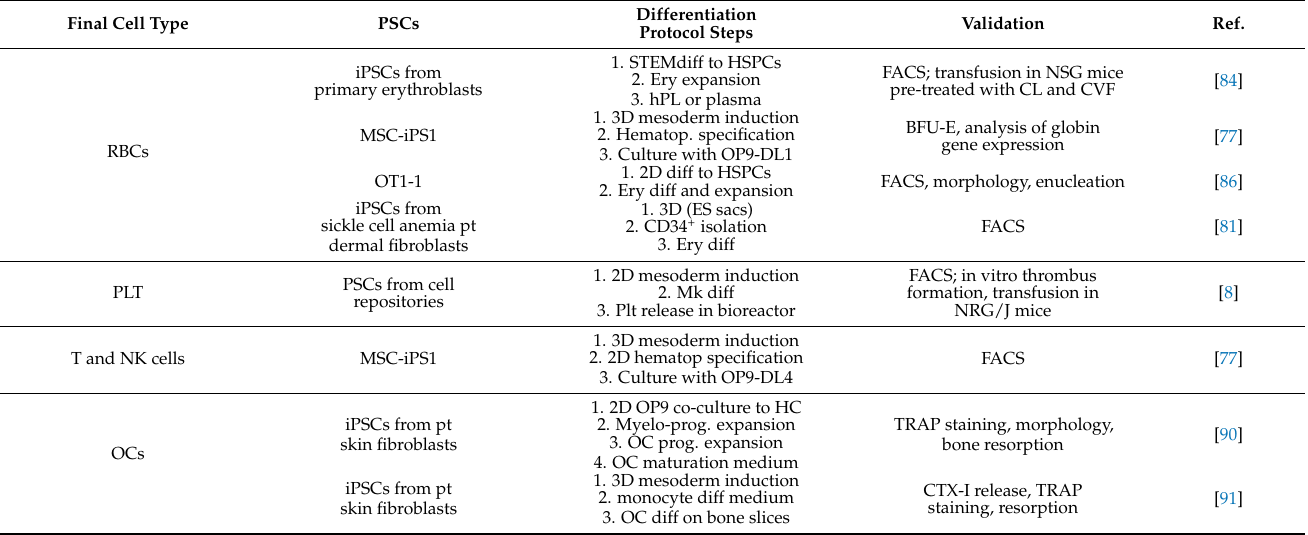
Table 1. Examples of generation of human adult-type differentiated hematopoietic cells in vitro from